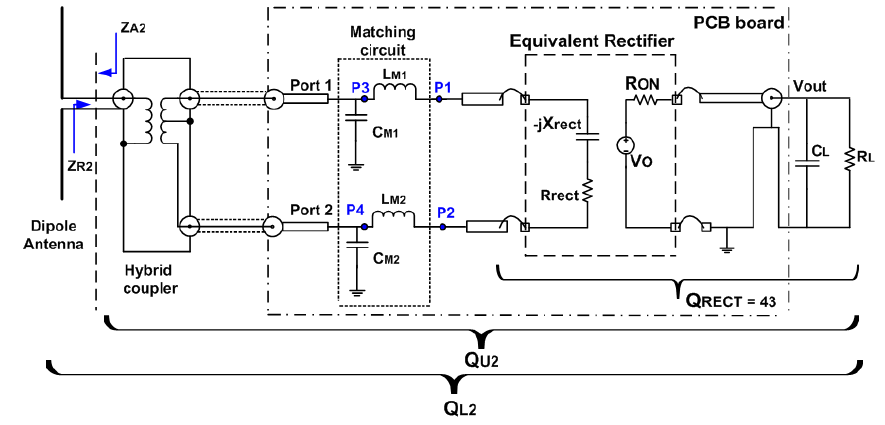
Figure 10. Equivalent of the RFEH scheme 2.